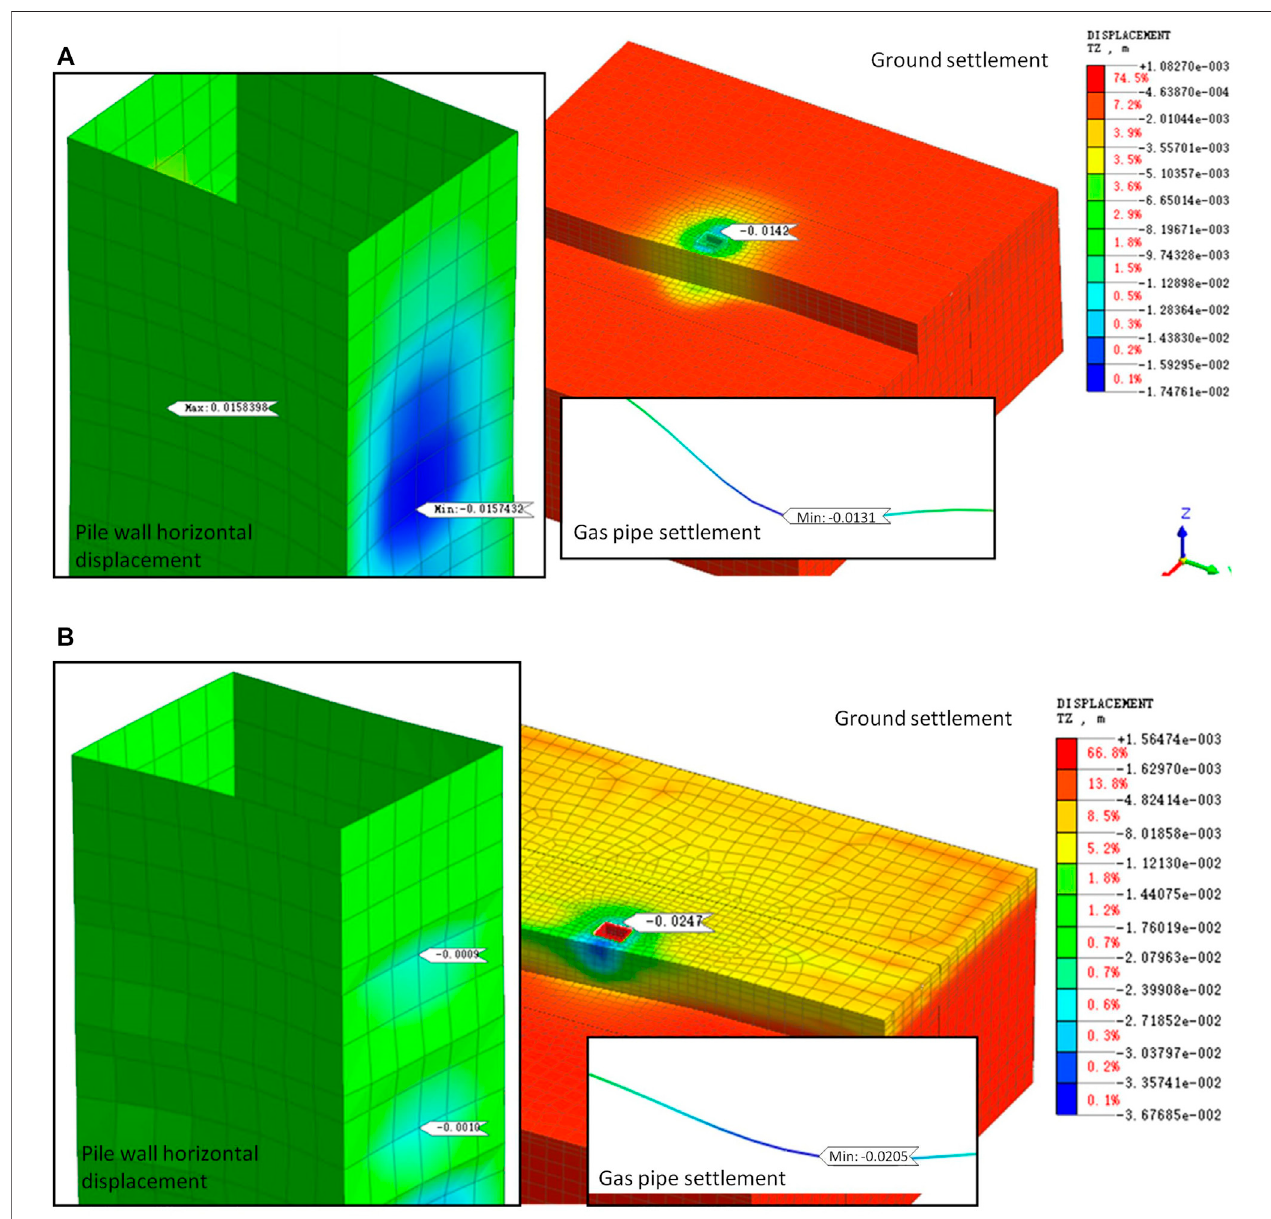
FIGURE 11 | Finite element analysis results: (A) shaft excavation but without loss of water; (B) only loss of water but without shaft excavation.